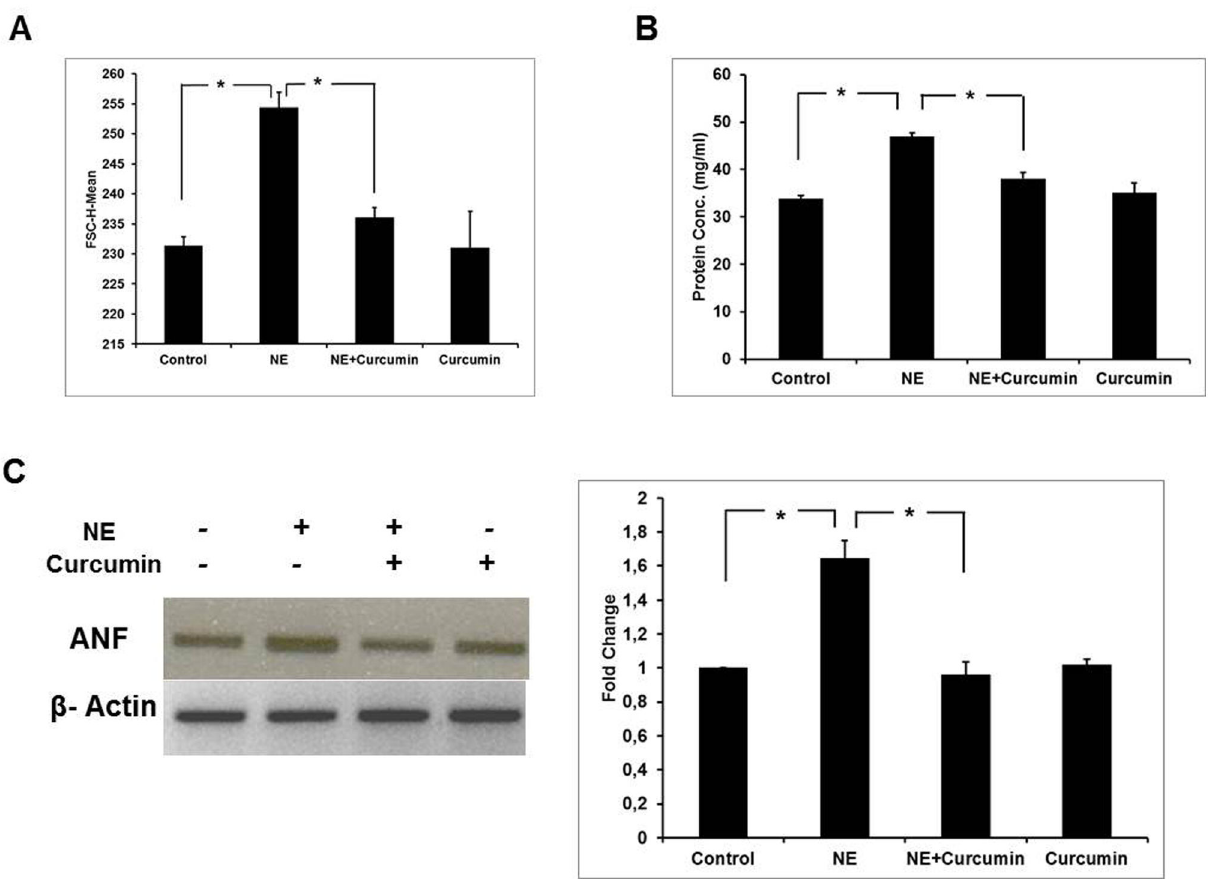
Figure 1. Curcumin prevents Norepinephrine induced cardiac stress in H9c2 cells. A ) Analysis of FACS Forward Scatter : Histogram represents comparison of cell size in Control (Uninduced cells), NE-treated (Hypertrophic), NE+Curcumin-treated and CurcuminNE-treated alone experimental groups (*P<0.01). B ) Analysis of protein content : The statistical representation of total protein concentration (mg/ml) for all four groups (*P<0.05). C ) RT-PCR analysis for ANF : Starting from left, samples in different lanes represent, Lane-1: Control; Lane-2: NE-treated; Lane-3: NE+Curcumin-treated; Lane-4: Curcumin-treated. The bands were quantitated by NIH ImageJ software and fold intensity with respect to control after normalization was plotted as a histogram (*P<0.05). The difference in NE-treated group was statistically significant in comparison to control and NE+Curcumin-treated groups in all experiments shown in the